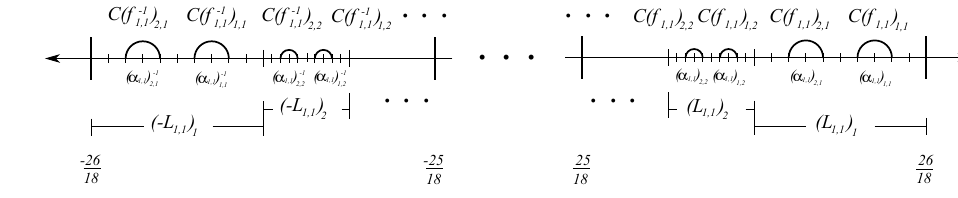
Figure 12: The closed intervals L 1,1 and − L 1,1